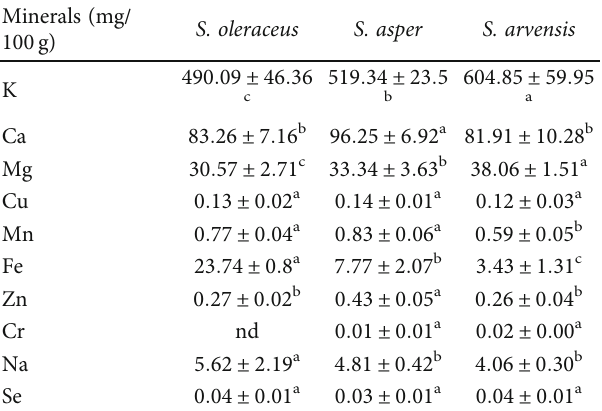
Values expressed in dry matter; mean of 3 replicates; data shown in mean ± standarddeviation . Means followed by the same letter on the line do not di ff er by the test of Duncan at the 5% level of signi fi